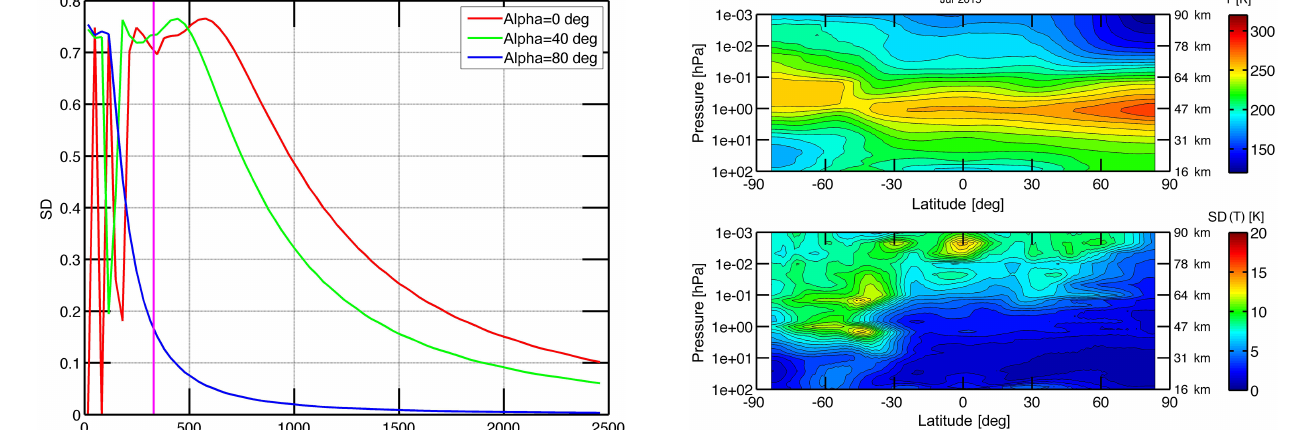
Figure 1. The standard deviation that is calculated by the five- consecutive-points method as a function of the horizontal wave- length λ h for artificial sine waves with an amplitude of 1. The pa- rameter α is the angle between the horizontal wave vector and the orbit of the sounding volume (0 ◦ is wave propagation along the or- bit; red line). The apparent wavelength is given by λ h / cos α . The magenta line denotes the Nyquist length when the wavelength is 2 times the sampling length of the near-polar orbit, which is about 165km. Generally, our method is sensitive to inertia-gravity waves with wavelengths between about 200 and 1500km. Planetary waves in zonal direction have a high value of α and are nicely suppressed by our method.